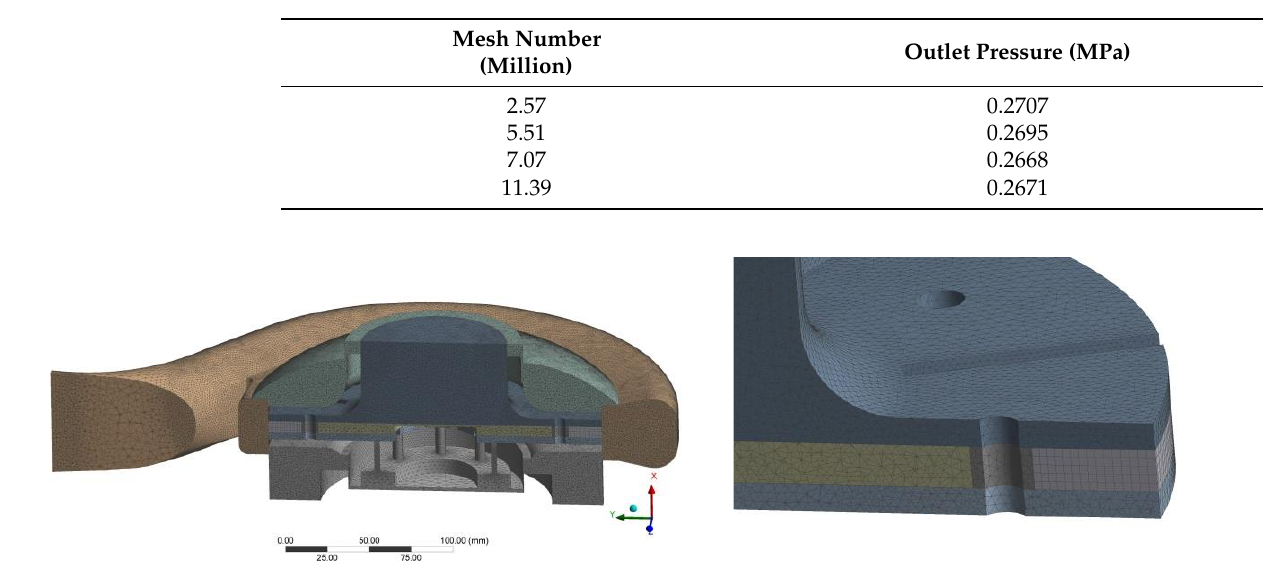
Table 2. Mesh independence validation.